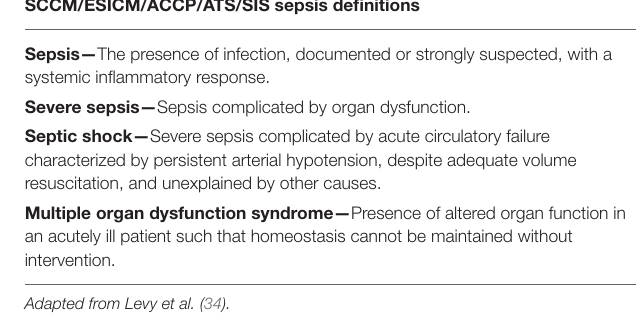
TABLE 1 | ACCP/SCCM consensus conference definitions (1991). ACCP/SCCM consensus conference definitions